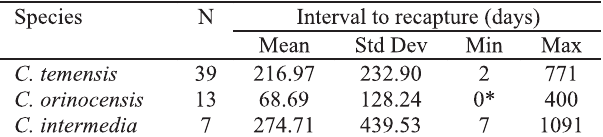
Table 1. Mean, minimum, and maximum number of days between tagging and recapture events for three species of Cichla in the Cinaruco River, Venezuela. *individual was recaptured after 2.5 hrs